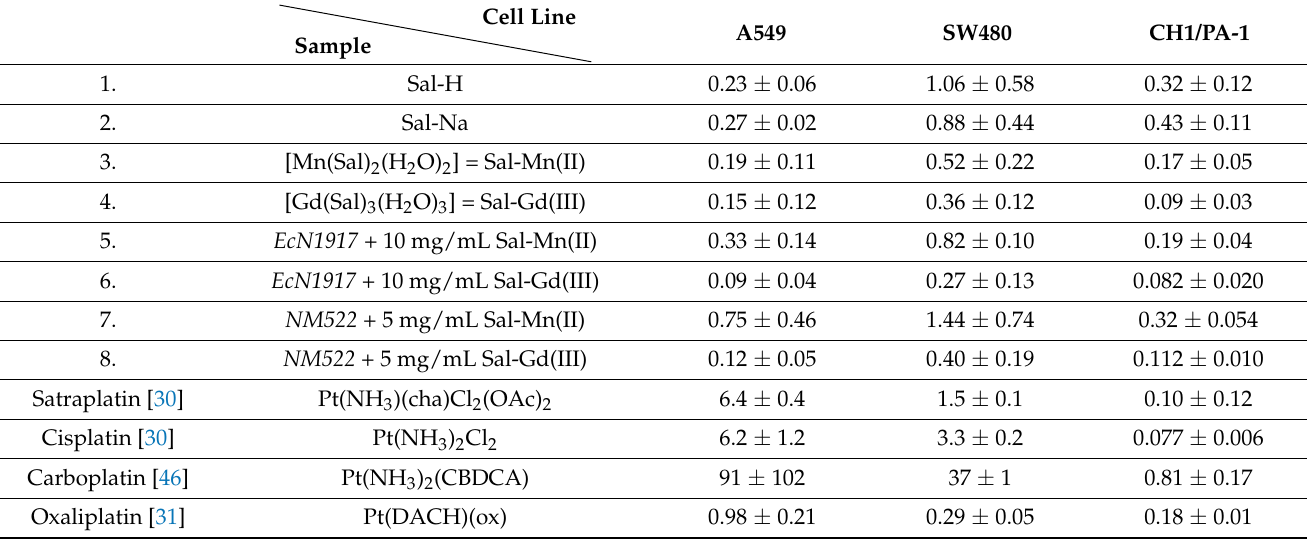
Table 3. Cytotoxic activity of paramagnetic complexes of salinomycin with Gd(III) and Mn(II), loaded BGs and Pt-containing clinical chemotherapeutics: mean IC 50 values (in µ M) ± standard deviations from at least three independent MTT assays in each of three human cancer cell